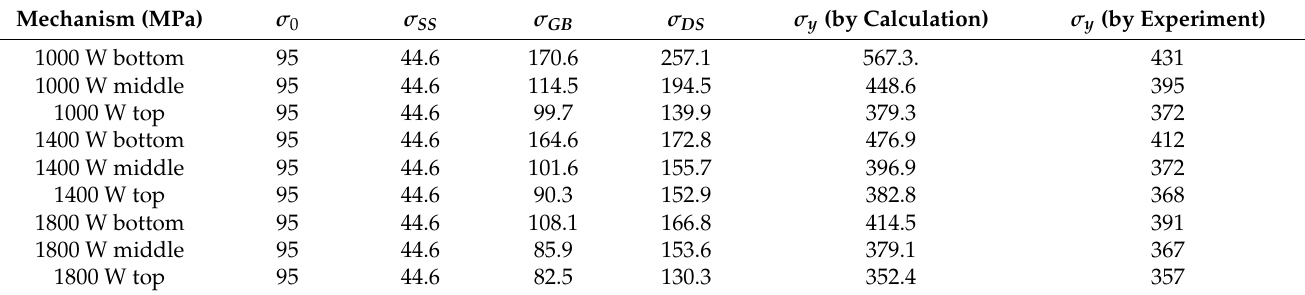
Table 3. Various strengthening mechanisms identified in LMD-ed Al 0.5 FeCoCrNi HEA.